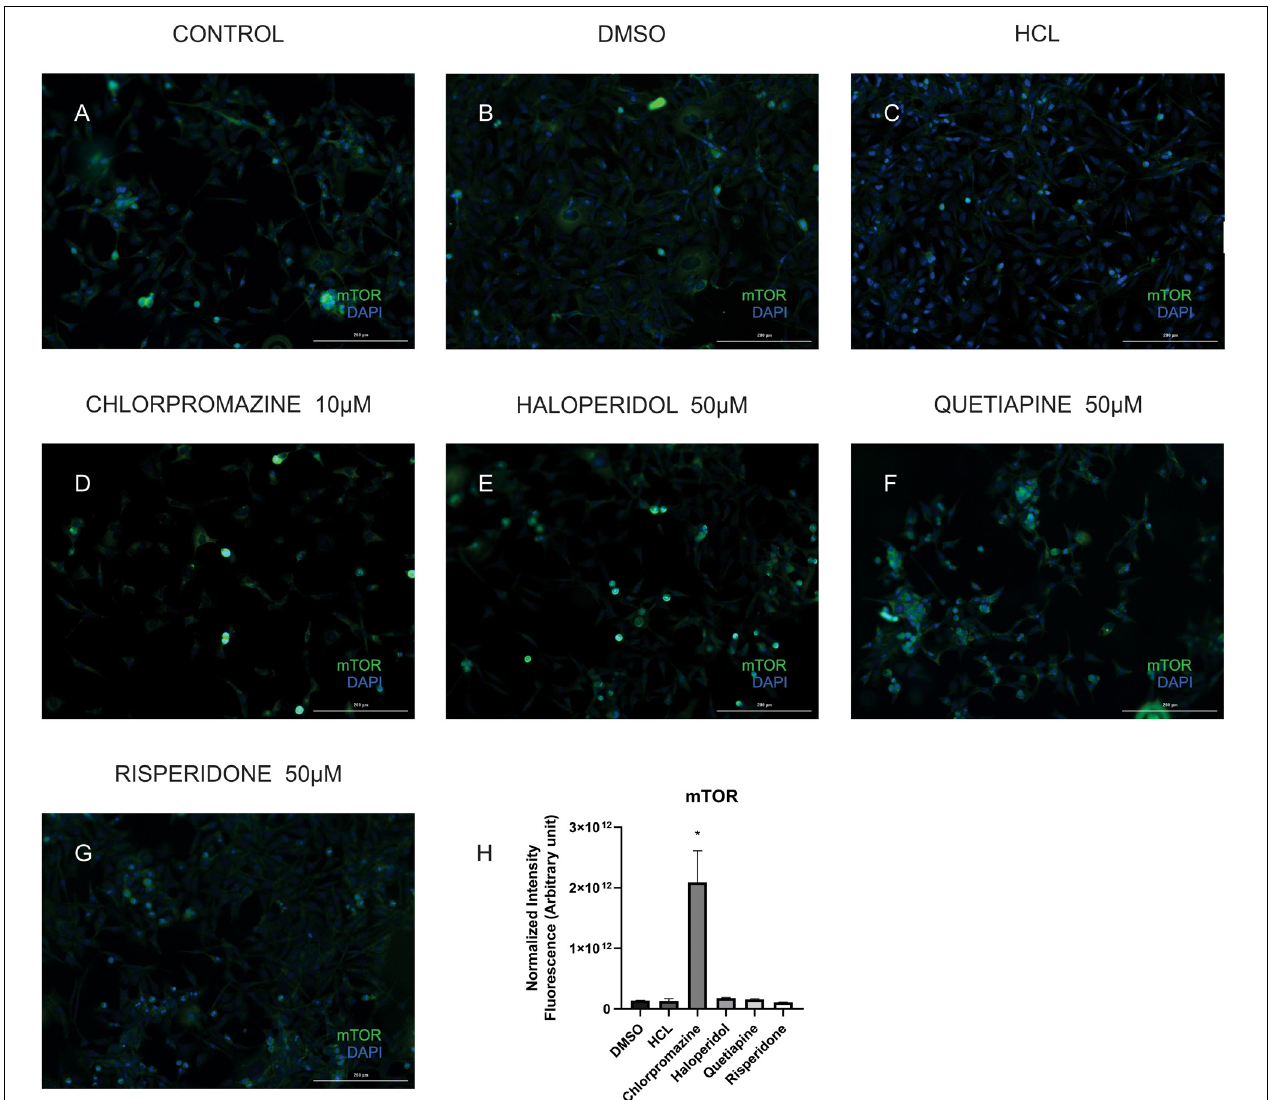
FIGURE 2 | Representative images of MO3.13 cells treated for 8 h (A) , vehicles (DMSO, HCl; B,C ), chlorpromazine 10 µ M (D) , haloperidol 50 µ M (E) , quetiapine 50 µ M (F) , and risperidone 50 µ M (G) stained for mTOR (green)/Dapi (blue). (H) Statistic chart showing normalized intensity fluorescence for mTOR for each treatment ( ∗ P < 0.05). Scale bars = 200 µ